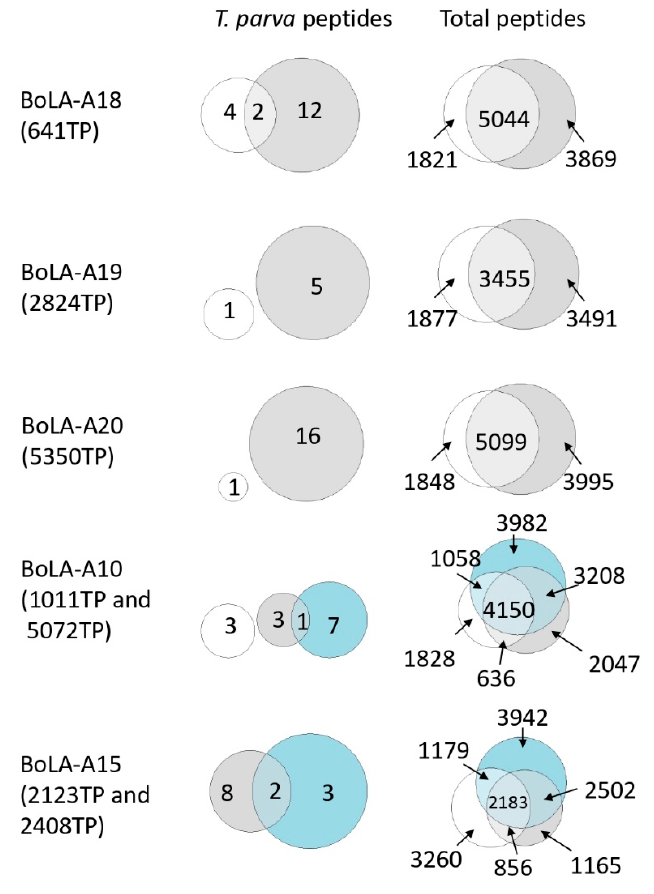
Figure 5. Overlap between the peptidomes identified from duplicate analysis of BoLA-A18, BoLA- A19, and BoLA-A20 samples and from samples sharing the BoLA-A10 and BoLA-A15 haplotypes. Euler diagrams displaying the overlap in the T. parva (left) and total (right) peptidomes of dupli- cated samples or samples sharing BoLA-I haplotypes. The number of peptides that are unique to each sample and shared between samples is indicated. The peptides identified in replicate samples were: BoLA-A18—RMDDKSGGLL from TpMuguga_01g00736 (hypothetical protein) and GEFEKKYIPTL from TpMuguga_01g00757 (Ras family protein); BoLA-A10—AGVELDTQKKFL from TpMuguga_03g00858 (multiprotein-bridging factor 1c); BoLA-A15—FEYEFPINH from Tp- Muguga_01g00471 (bifunctional thioredoxin reductase/thioredoxin); and EEIAHVLHY from Tp- Muguga_01g02030 (hypothetical protein). Note that in the BoLA-A15 group, there were no T. parva peptides identified in sample 2123TP and so this sample is not represented in the T. parva euler